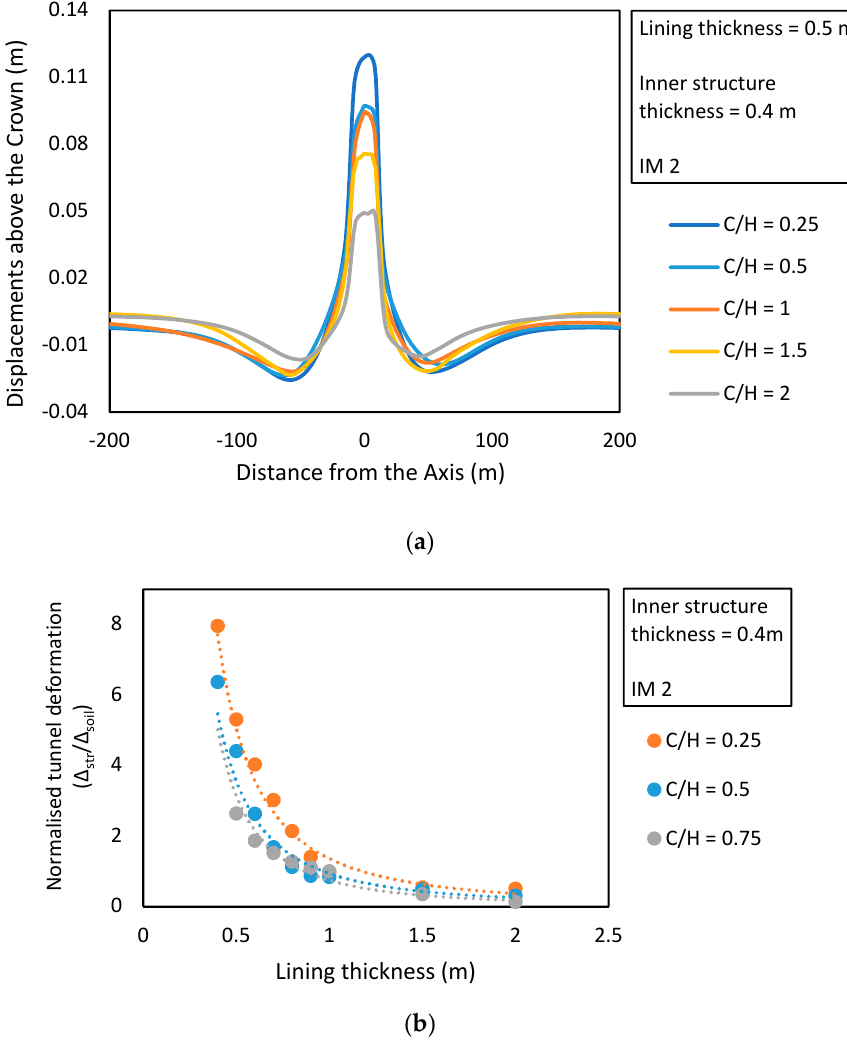
Figure 7. ( a , b ) Effect of variation in the embedment depth on: ( a ) surface settlements and ( b ) normalized tunnel deformations.